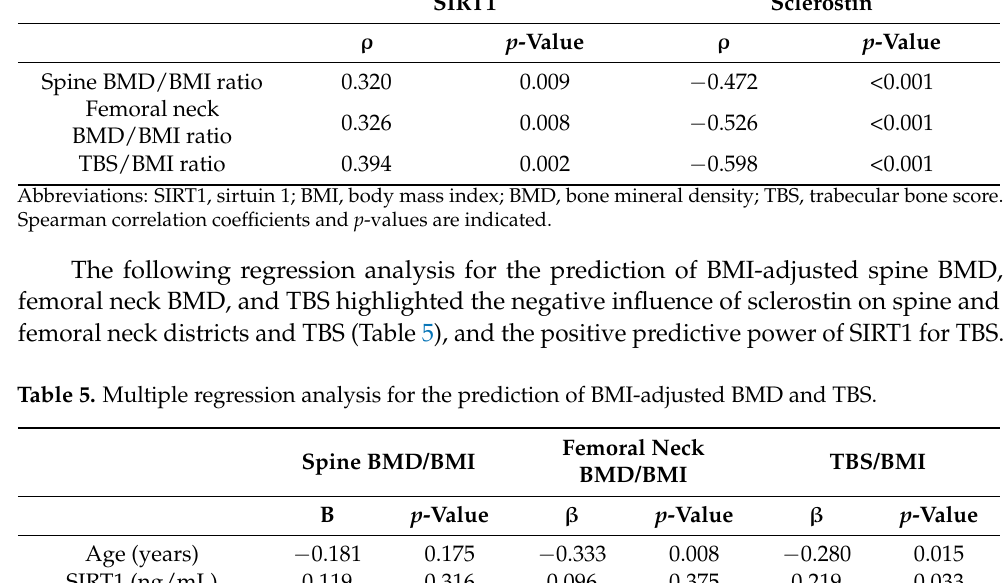
Table 4. Correlation analysis between SIRT1 and sclerostin and BMI-adjusted BMD and TBS.